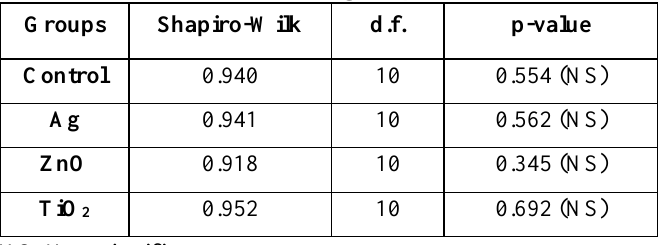
Table 1: Testing the normality of data distribution for the antimicrobial test in the various groups.